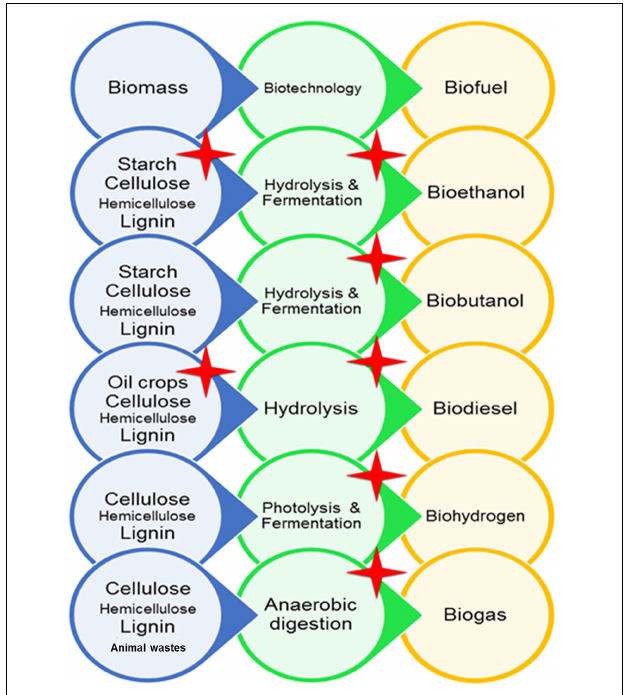
FIGURE 1 | Different ways of production of different types of biofuels. Red stars show the processes in which the effect of halophilic microorganisms is reported in biofuel